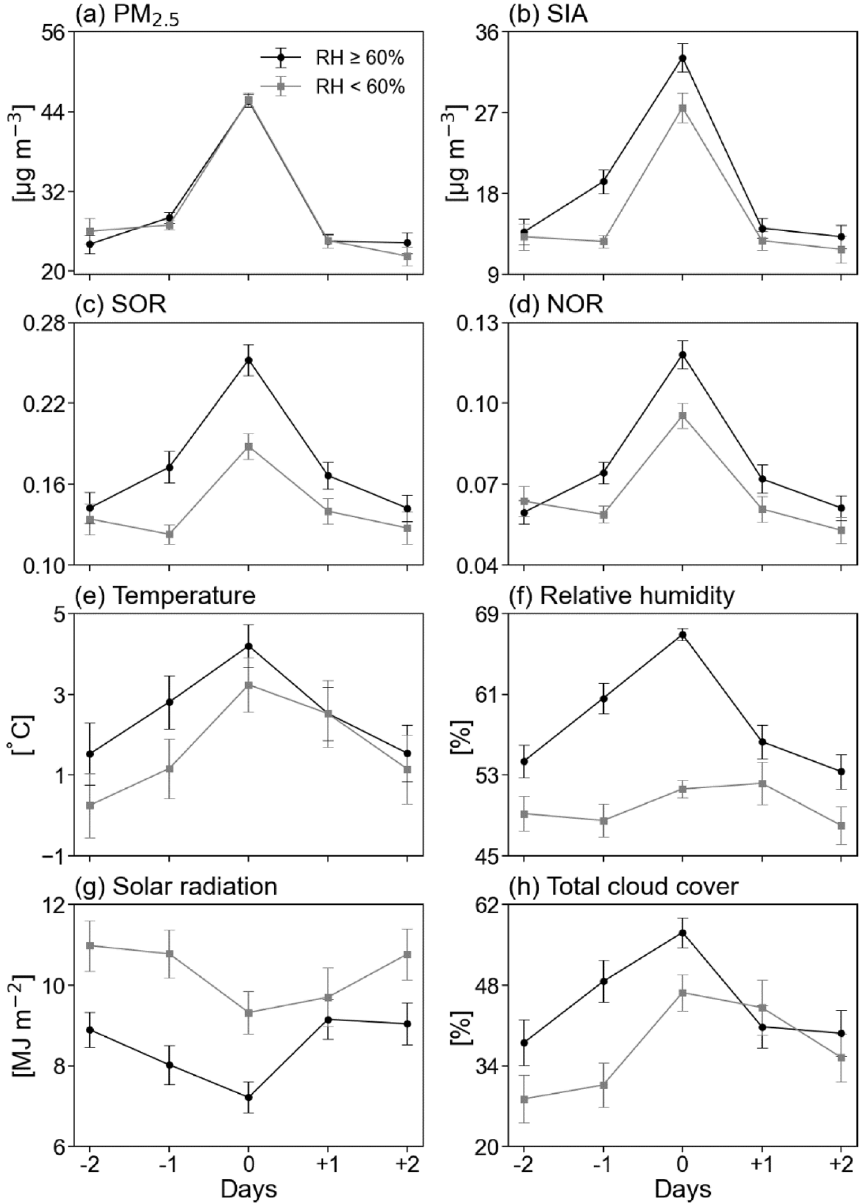
Figure 3. Daily mean concentrations of ( a ) PM 2.5 , ( b ) SIA, ( c ) SOR, ( d ) NOR, ( e ) temperature, ( f ) RH, ( g ) solar radiation, and ( h ) total cloud cover for the period from Day − 2 to Day + 2 of high-PM 2.5 episodes under wet condition (RH ≥ 60%) and dry condition (RH <